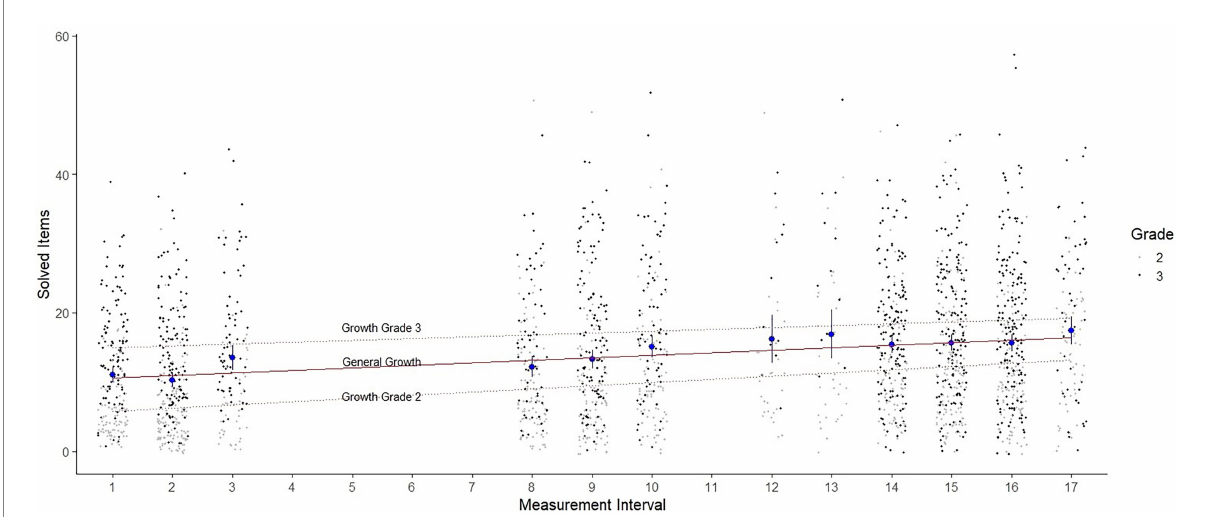
FIGURE 3 Jitter plot with the distribution of scores in the 12 LPM measurement intervals. The red line illustrates the general learning growth. The light dashed lines illustrate the growth for grade 2 and grade 3. The blue dots show the mean value as well as the confidence intervals of the respective measurement intervals for the overall sample.